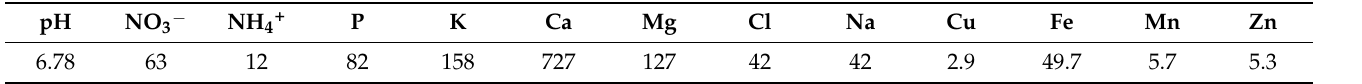
Table 4. Soil parameters * (pH and the content of main nutrients (mg/L)).